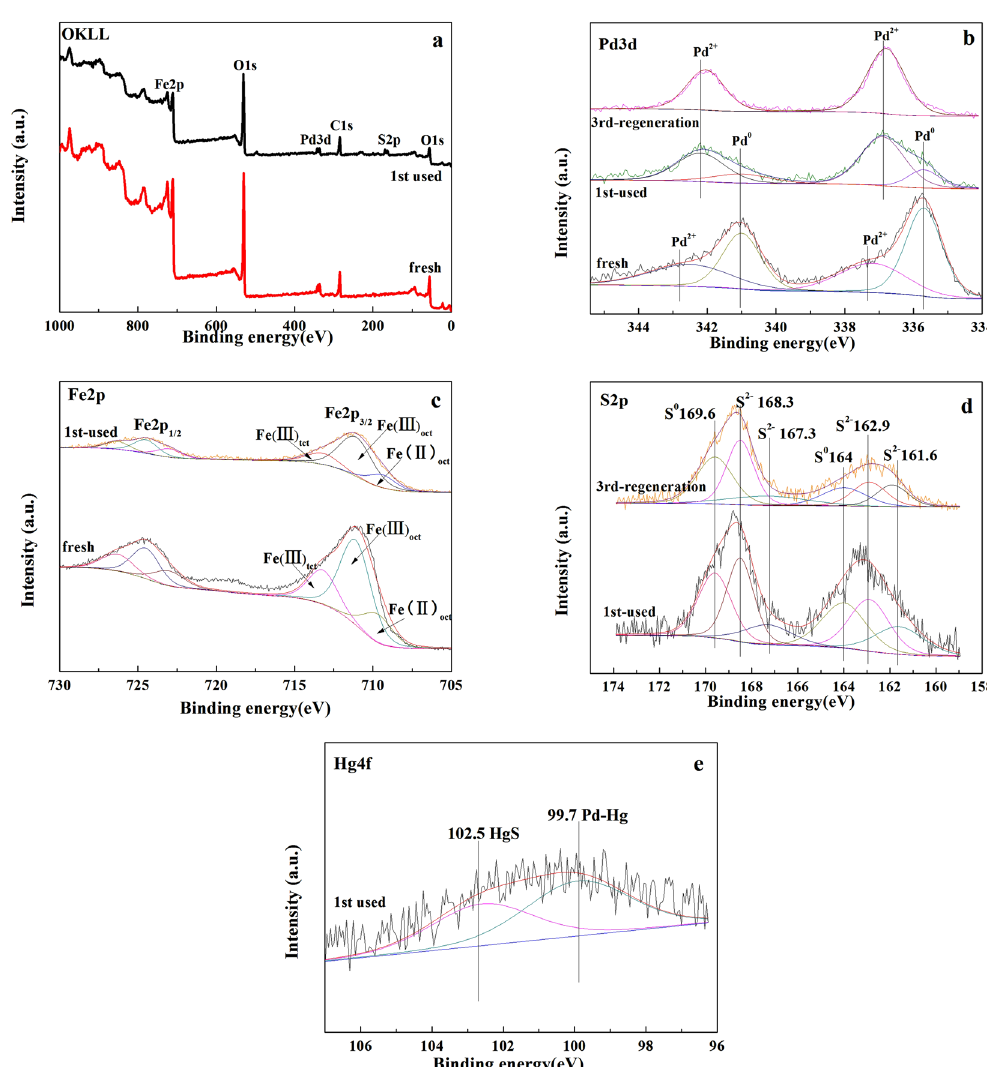
Figure 9. XPS spectra of Fe 3 O 4 –NH 2 –Pd sorbents: ( a ) survey scan and high-resolution scan of ( b ) Pd3d, ( c ) Fe2p, ( d ) S2p and ( e )